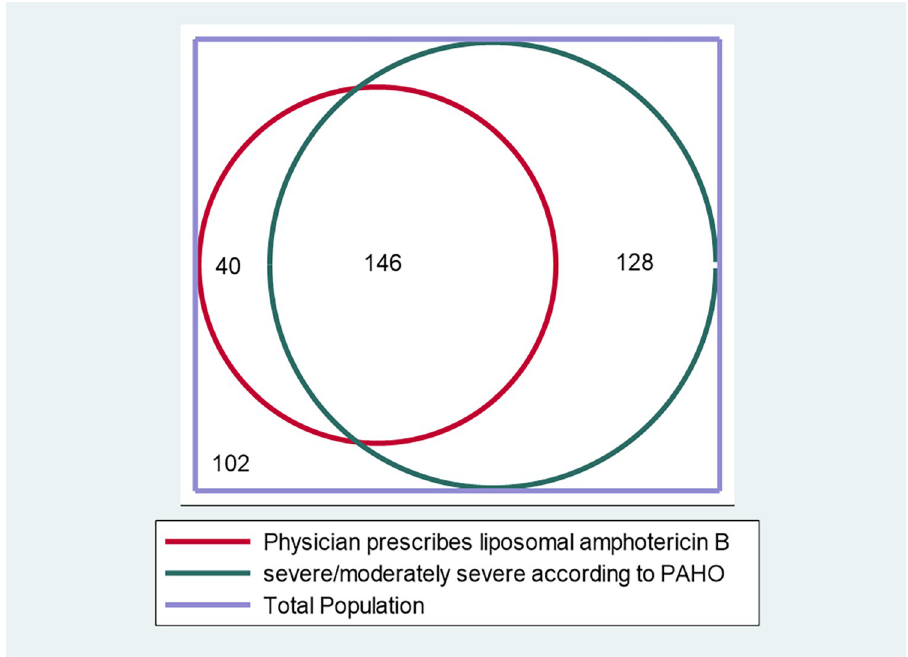
Fig 3. Venn diagram representing the concordance between the PAHO/WHO guideline definition of severe/ moderately severe and first line treatment.